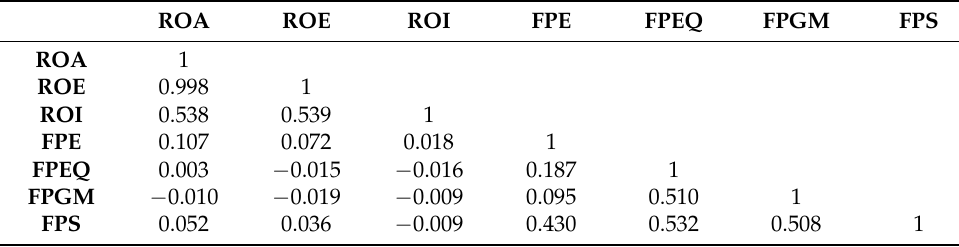
Table 8. The correlation matrix for electricity companies.